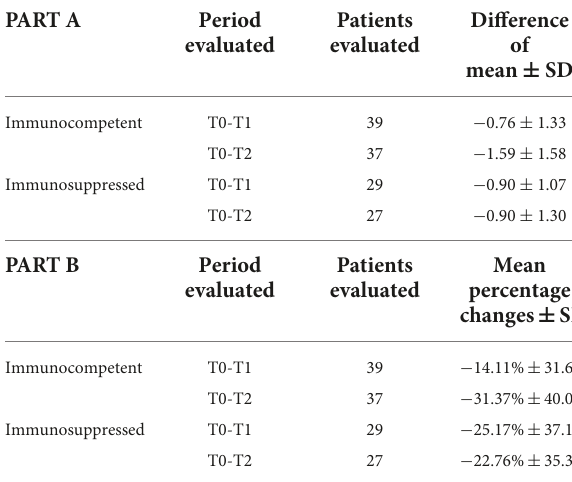
TABLE 4 Association between risk factors and anamnestic data with the mean AKASI score at T0.